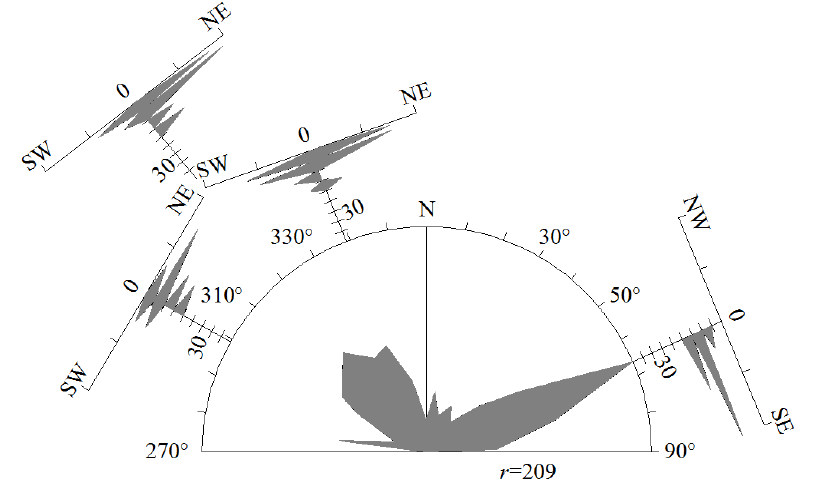
Figure 3. Rose diagram of discontinuous surfaces in study area.